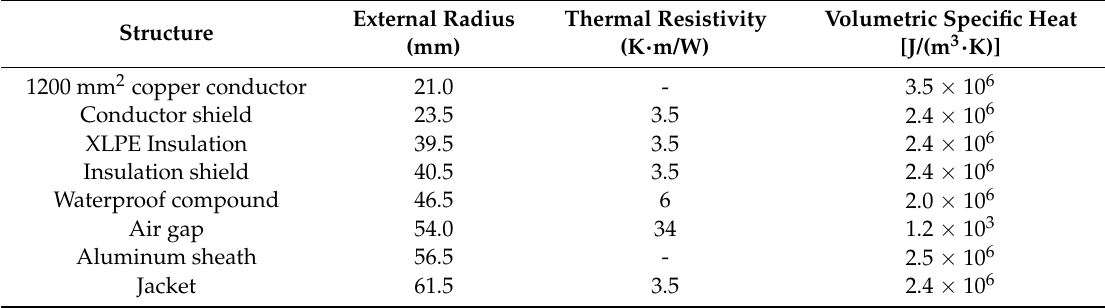
Table 2. Parameters of the tested 110 kV single-core cross-linked polyethylene (XLPE) cable. Structure